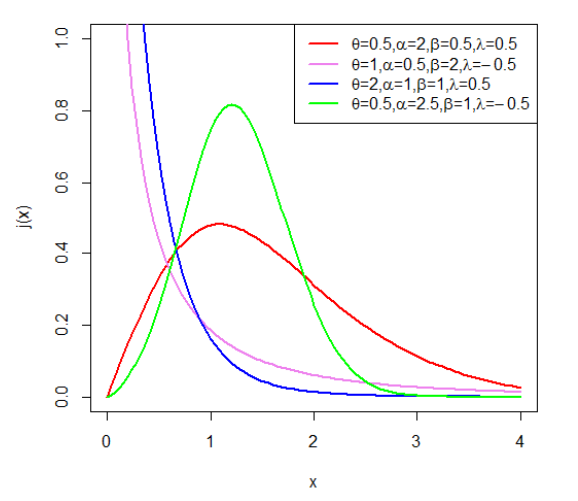
Figure 5 – Pdf of ET W distribution for various choices of θ , α , β and λ